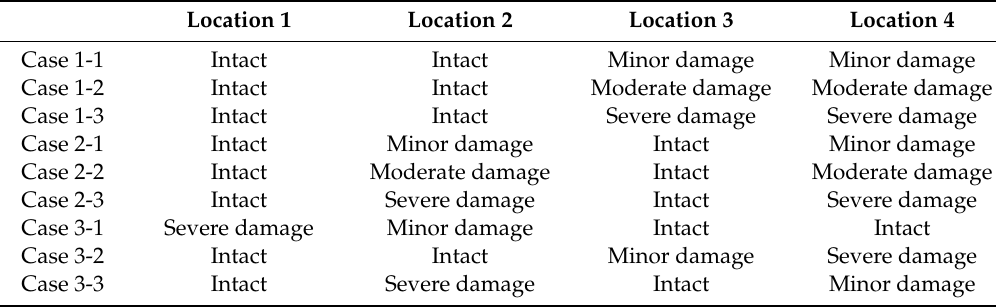
Table 2. Damage severity at di ff erent locations on the pipe.